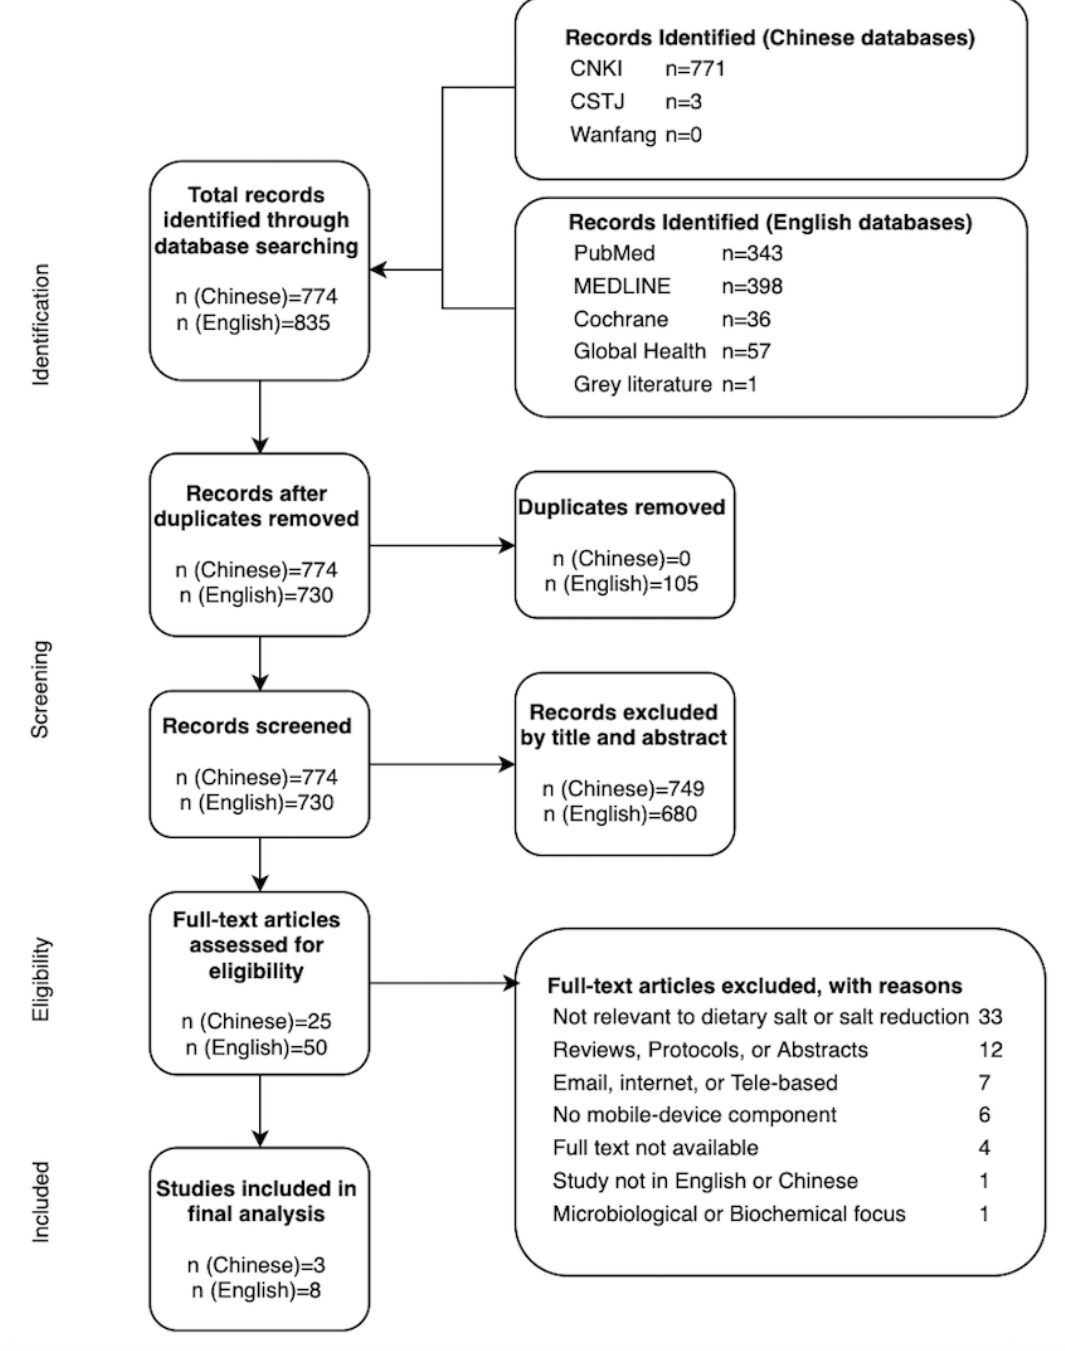
Figure 1. Study flowchart. CNKI: China National Knowledge Infrastructure; CSTJ: China Science and Technology